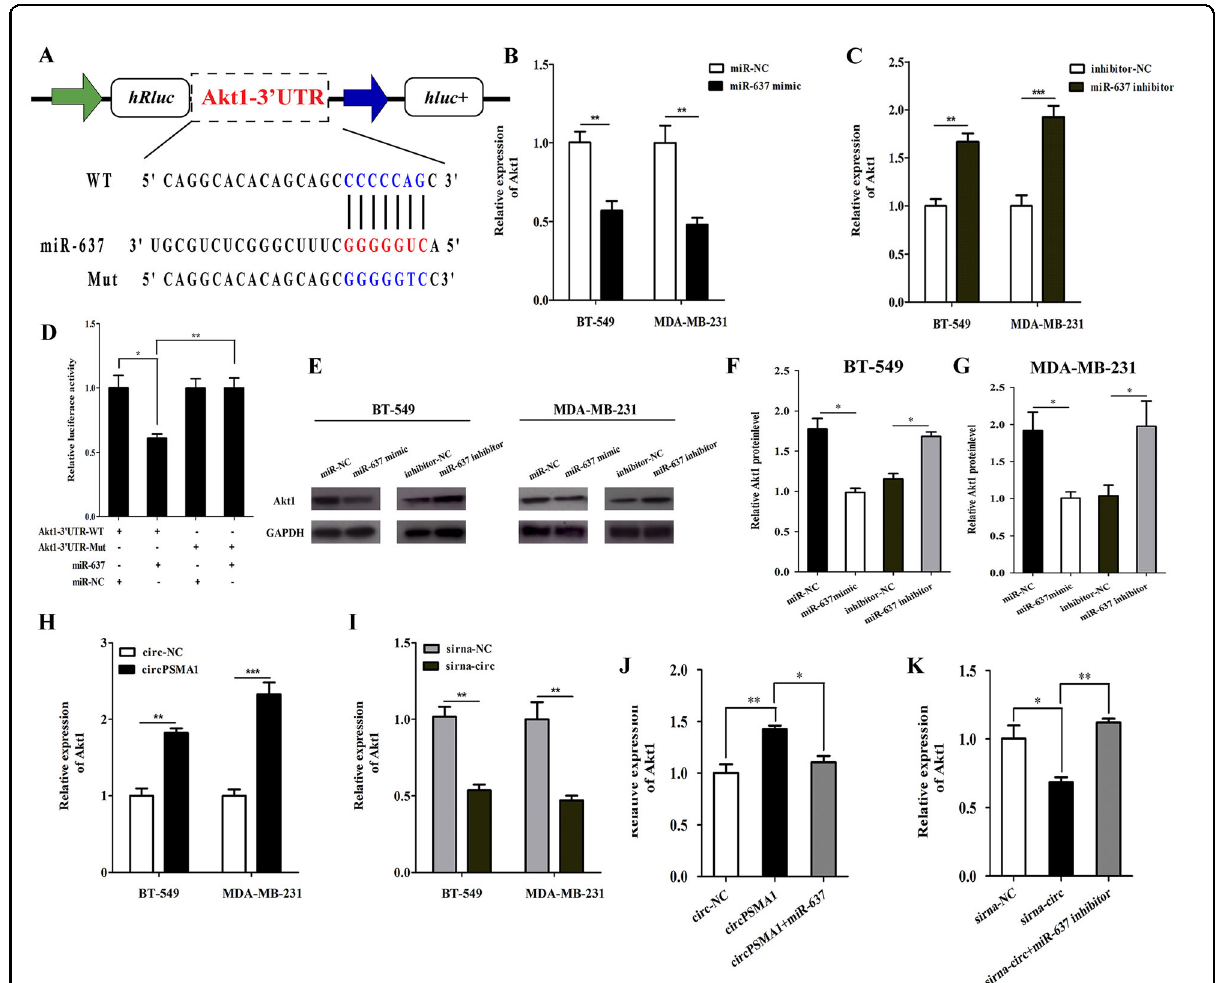
Fig. 5 MiR-637 inhibits TNBC cell proliferation, migration, and metastasis by directly targeted Akt1. A Schematic illustration of Akt1-3 ′ UTR-WT and Akt1-3 ′ UTR-Mut luciferase reporter vectors and the miR-637 binding site on Akt1 that predicted by TargetScan (http://www.targetscan.org/ vert_72/). B The dual-luciferase reporter assay was carried out to validate whether miR-637 could directly bind to the 3 ′ -UTR of Akt1. After cotransfected Akt1-3 ′ UTR-WT and Akt1-3 ′ UTR-Mut luciferase reporter vectors with miR-637 mimic or NC respectively, the relative luciferase activities were detected by spectramax. C – G The relative expression of Akt1 after overexpression or knockdown of miR-637 by transfected with miR-637 mimic, miR-637 inhibitor, mimic-NC or inhibitor-NC was detected by qRT-PCR and western blot, respectively. H – I The relative expression of Akt1 in TNBC cells after overexpression or knockdown of circPSMA1 was detected by qRT-PCR. J – K The relative expression of Akt1 after cotransfecting the indicated vectors with miR-637 mimic, miR-637 inhibitor, mimic-NC or inhibitor-NC. Data were shown as mean ± SD at least three independent experiments, * p < 0.05, ** p < 0.01, *** p <